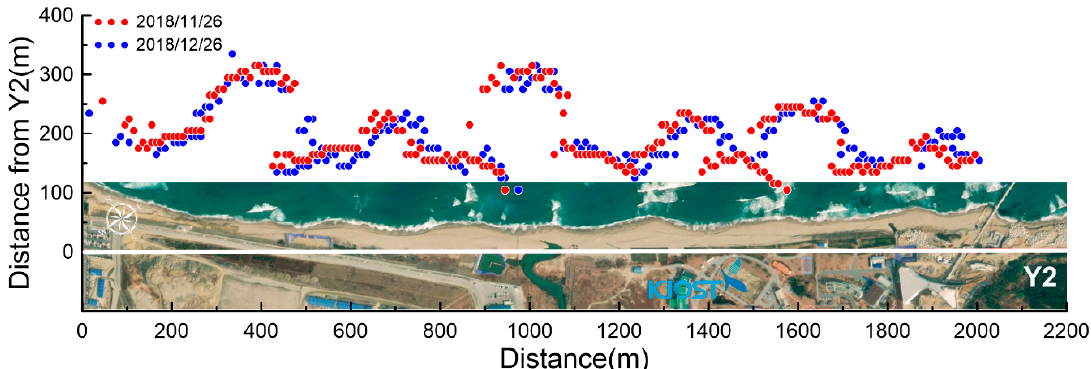
Figure 11. Comparison of crescentic sandbar crest positions between the Sentinel-II images on November 26, 2018 ( blue dots ) and December 26, 2018 ( red dots ), extracted using the algorithm by [21]. The sandbar crest positions showed no clear difference between the three dates except some parts, indicating the seabed morphology was stable during the period. The data were not estimated at the profiles where the peak was not detected by the algorithm.